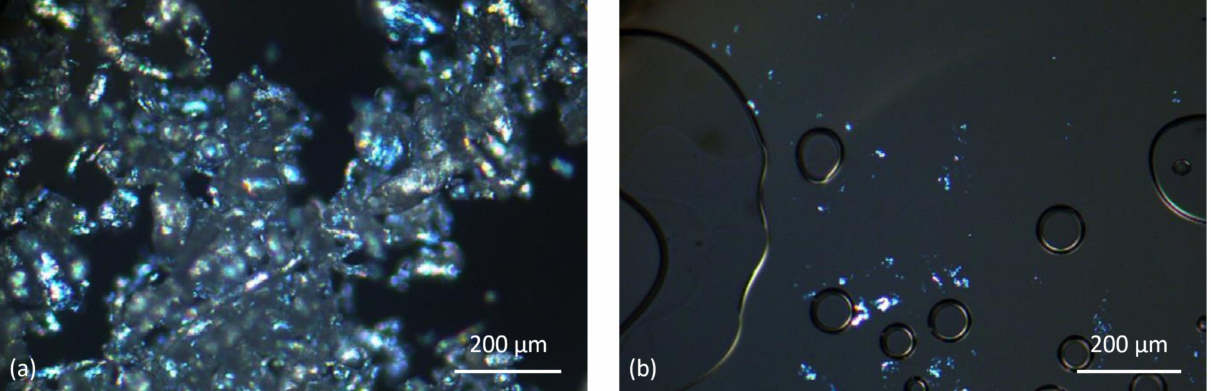
Figure 5. ( a ) Hot stage microscopy of PET powder under crossed polarisers showed softening of particles at 254 ◦ C. ( b ) Polarising hot stage microscopy of PET powder at 272 ◦ C under crossed polarisers, most of the material has melted, coalesced and spread, but there are residual birefringent specks that do not disappear till 280 ◦ C. Circular areas are bubbles with no melt.